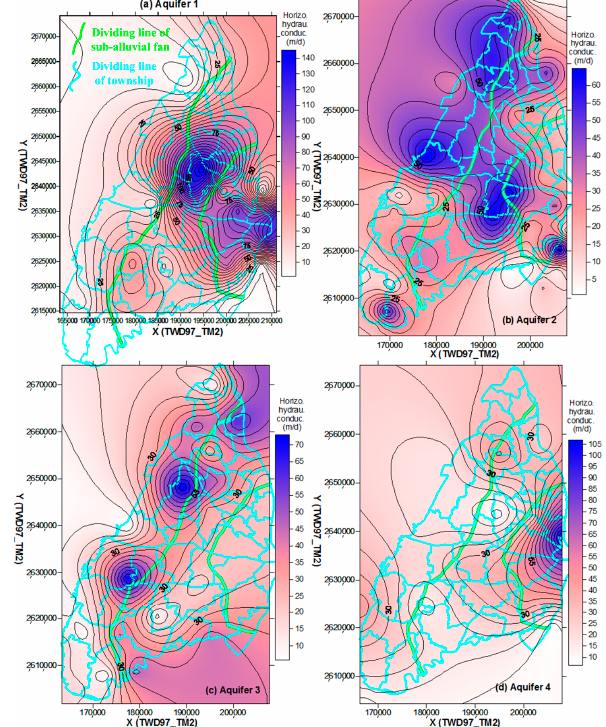
Figure 12. The identified spatial pattern of aquifer’s hydraulic conductivity K aqu Aquifer 2; ( c ) Aquifer 3; and ( d ) Aquifer